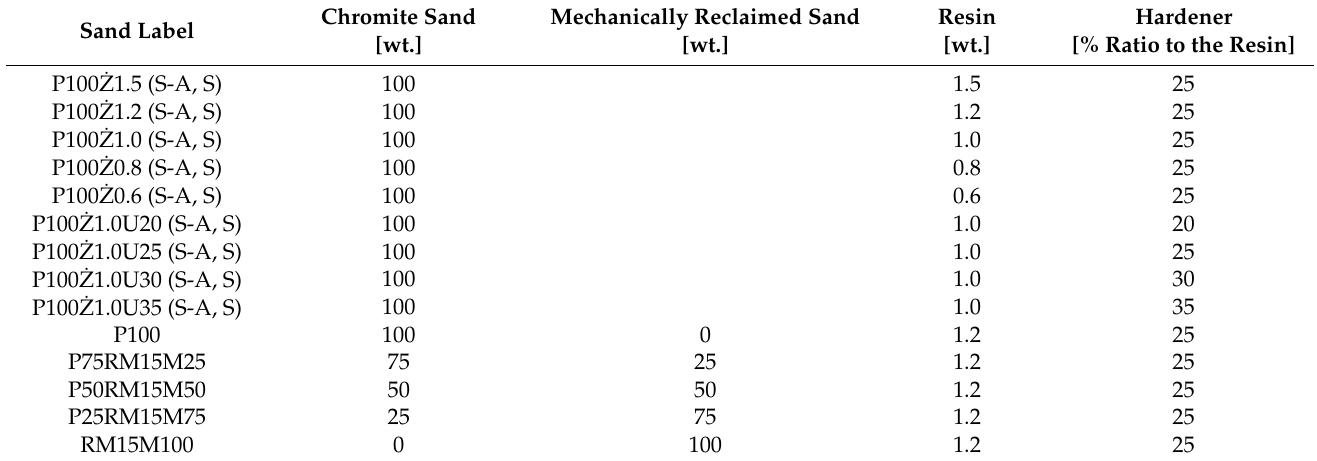
Table 1. Composition of molding sands with an alkaline-phenolic